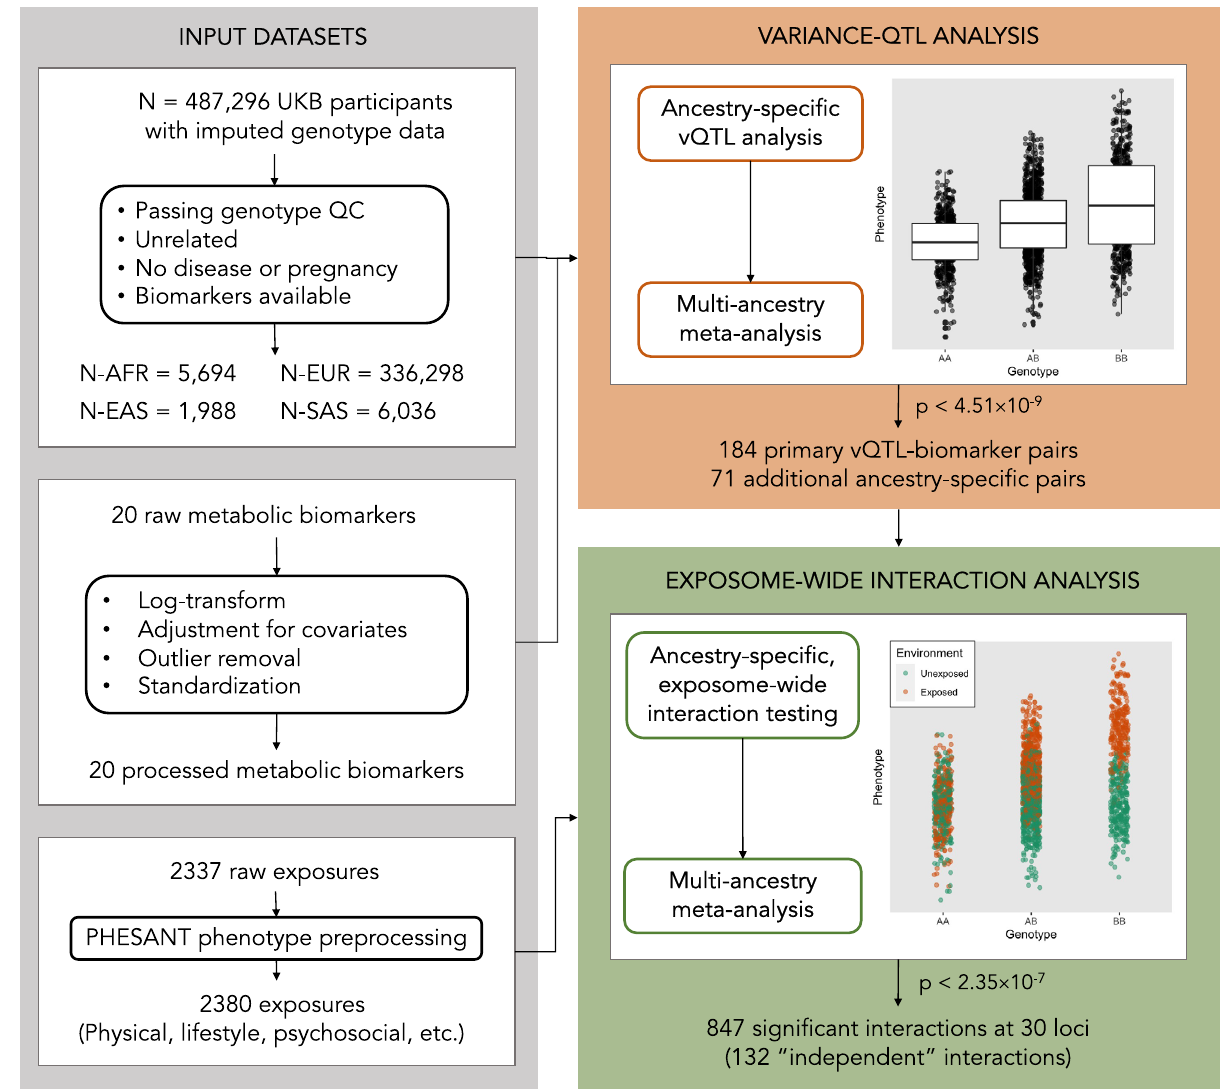
Fig. 1 Analysis work fl ow. Unrelated individuals without major disease from any of four ancestry groups in the UK Biobank were included in the analysis. Twenty metabolic biomarkers were pre-processed, including log transformation, adjustment for biological and technical covariates, and outlier removal. vQTL analysis was performed genome-wide, separately in each ancestry group followed by a multi-ancestry meta-analysis. Signi fi cant variant-biomarker pairs were taken forward for GEI analysis, along with 2380 exposures pre-processed using the PHESANT tool. Finally, GEI tests were performed for each combination of variant-biomarker-exposure triplet, again using ancestry-strati fi ed analysis followed by